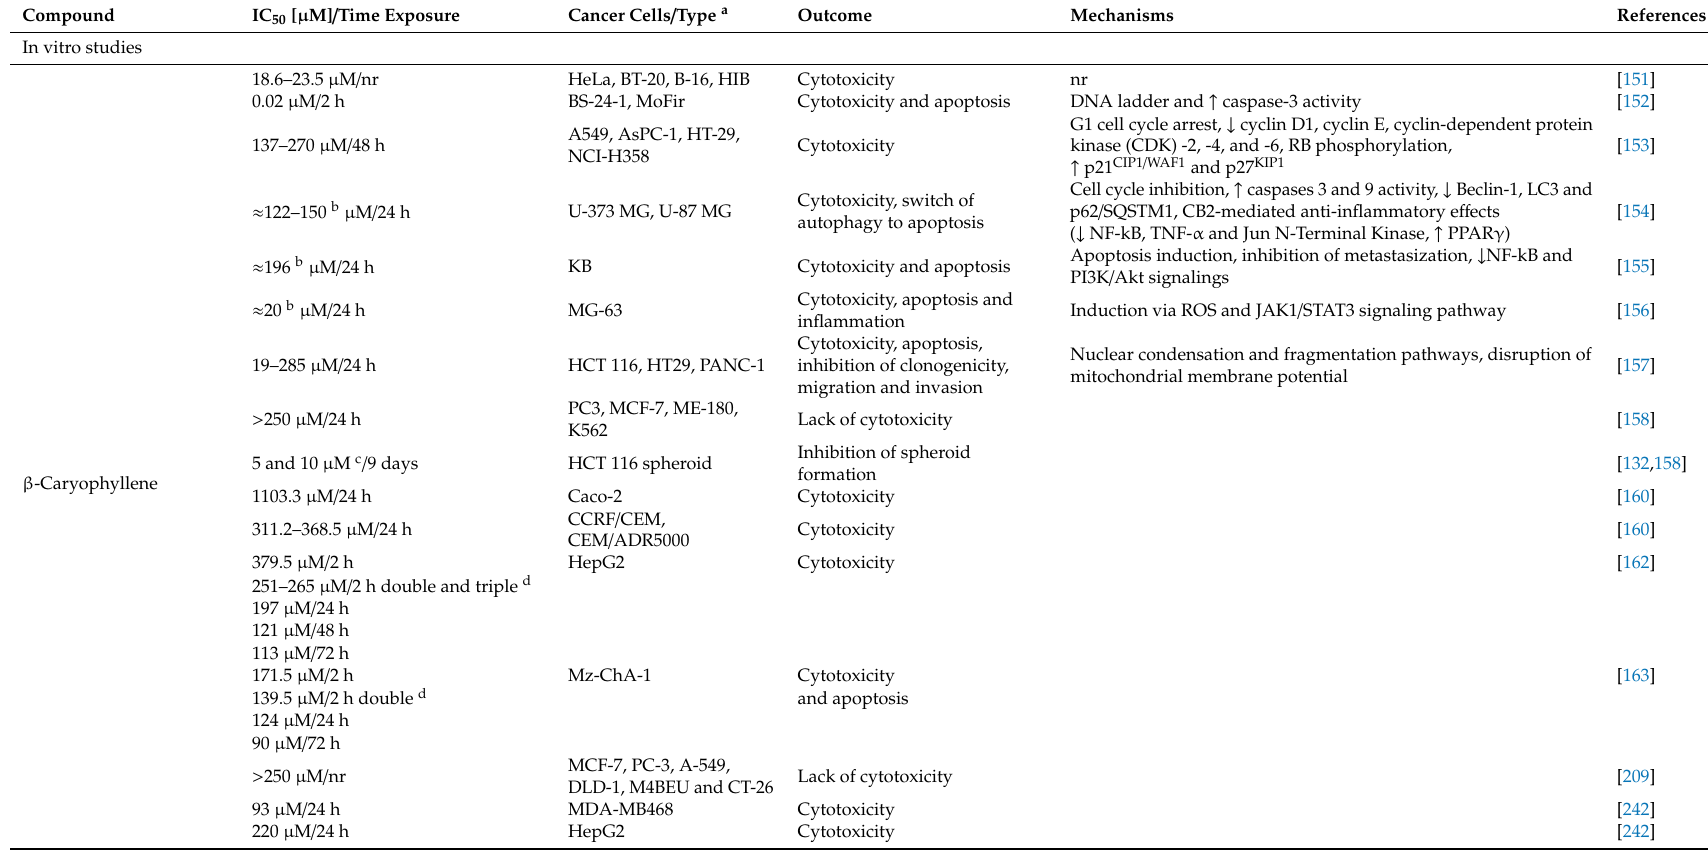
Table 4. Evidence about the ability of caryophyllane sesquiterpenes to a ff ect cancer growth and